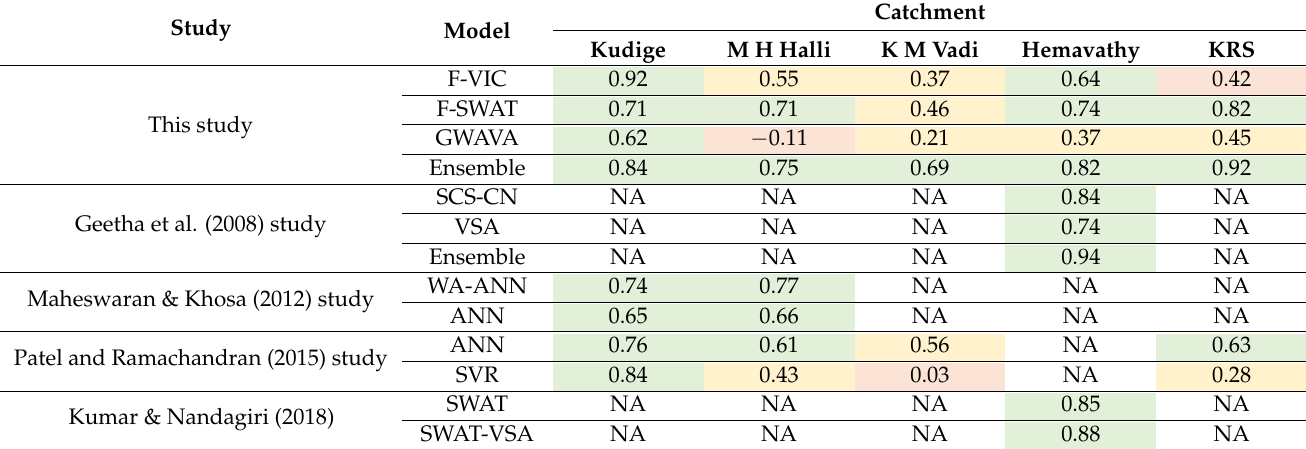
Table 5. A comparison of the NSE values obtained by models (F-VIC, F-SWAT and GWAVA) used in this study and the models (ANN and SVR) used in the Patel and Ramachandran (2015) study. The values lying in the green shaded area are considered by this study as ‘good’ and the red area as ‘poor’. The catchments that were not considered in the study are presented as